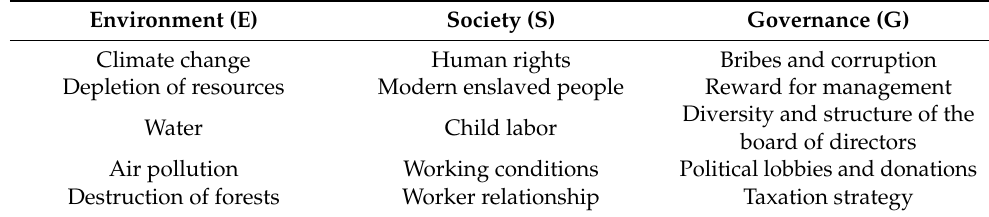
Table 1. Major factors of ESG items. Environment (E) Society (S) Governance (G) Climate change Human rights Bribes and corruption Depletion of resources Modern enslaved people Reward for management Diversity and structure of the Water Child labor board of directors Air pollution Working conditions Political lobbies and donations Destruction of forests Worker relationship Taxation